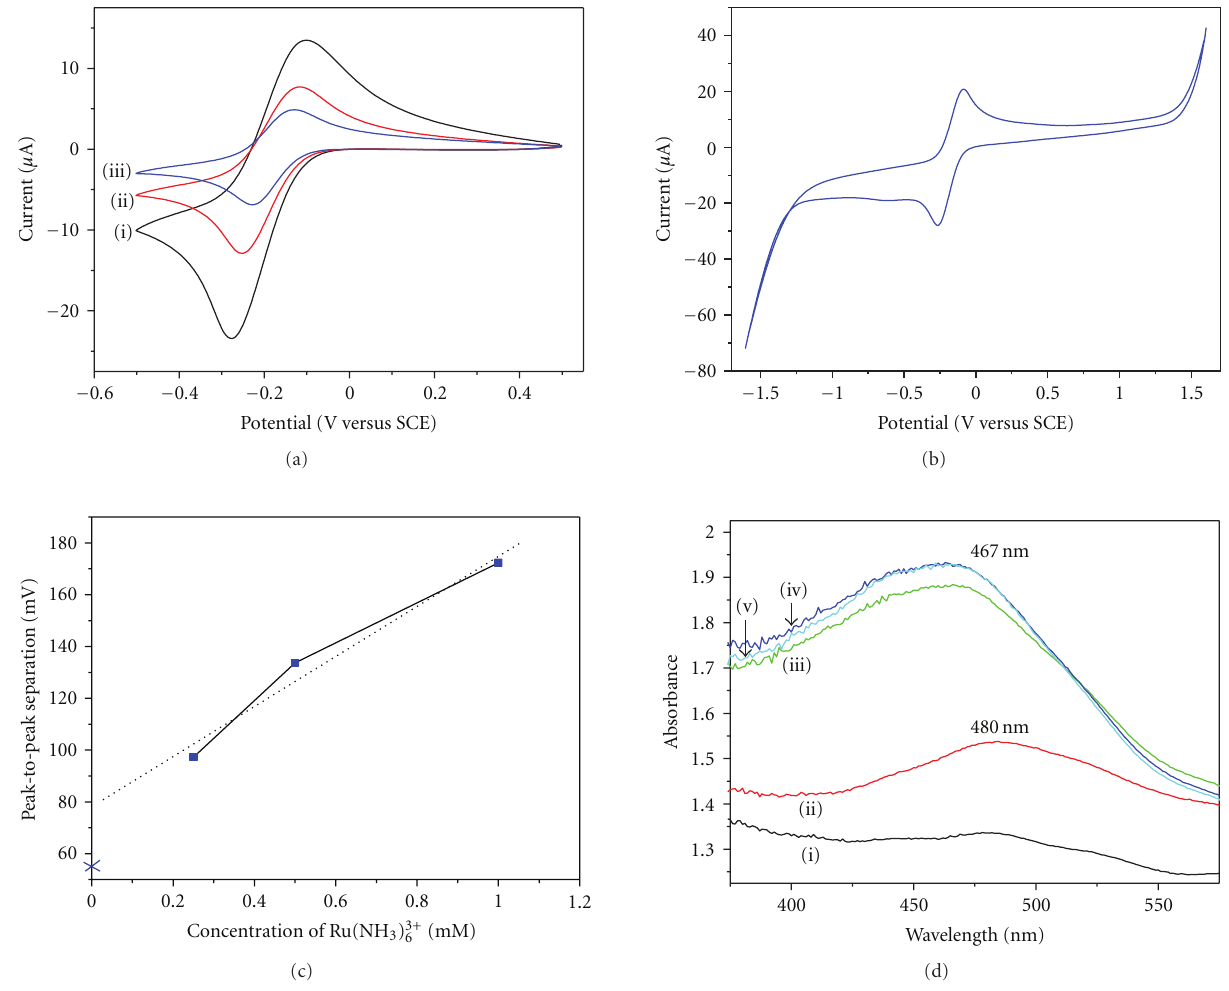
Figure 5: (a) Background corrected cyclic voltammograms of diamond hybrid OTE in Ru(NH 3 ) 3+ 6 of di ff erent concentrations in 0.1 M acetate bu ff er: (i) 1000 μ M, (ii) 500 μ M, and (iii) 250 μ M, with scan rate of 50mV/s. (b) The cyclic voltammogram of diamond hybrid OTE in 1mM Ru(NH 3 ) 3+ 6 in 0.1 M acetate bu ff er, scan rate 50mV/s, showing a wide potential window from − 1.35 to 1.5 V. (c) The peak-to- peak separation in voltammograms with di ff ering Ru(NH 3 ) 3+ 6 concentrations for diamond hybrid OTE, with scan rate 50mV/s. The ideal Nernstian system exhibits a peak separation of 59.2 mV which is marked as a crossing in the Y -axis. (d) UV-Vis spectroscopy of 1mM 4- aminophenol in 0.1 M acetate bu ff er of pH 4.6 with a BDD OTE at di ff ering applied potentials: (i) 0.1 V, (ii) 0.12 V, (iii) 0.14 V, (iv) 0.16 V, and (v) 0.18